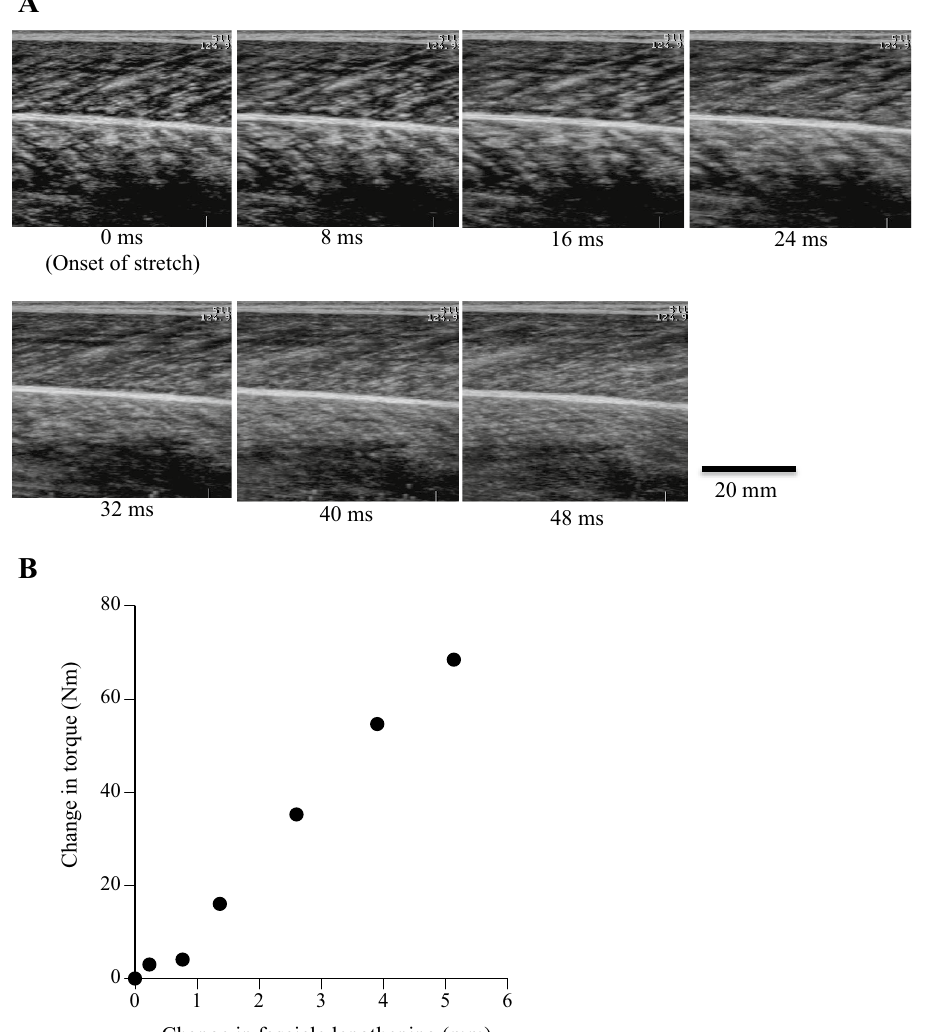
Figure 5. ( A ) Ultrasonic images of longitudinal sections of the medial gastrocnemius muscle during the measurement of active muscle stiffness at 600 deg s −1 . (B) Typical example of the change in torque and fascicle lengthening during the measurement of active muscle stiffness at 600 deg s −1